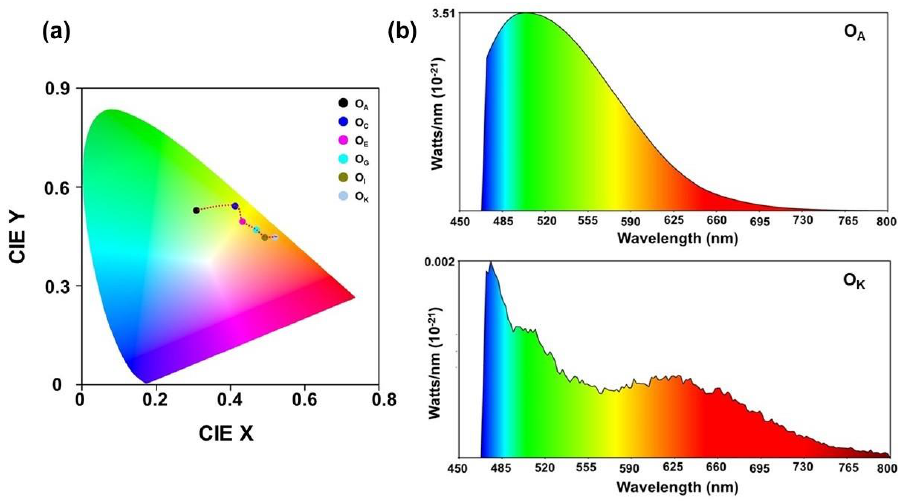
Figure 7. ( a ) The CIE plot of samples — O A , O C , O E , O G , O I , and O K and the ( b ) power spectrum for the samples — O A and O K.